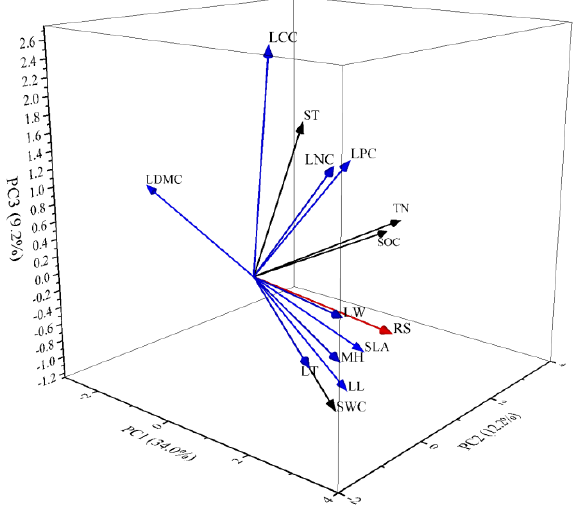
Figure 4. MFA ordination of soil respiration and community functional traits. (Legend: The direc- tion of the arrow indicates the positive and negative correlations between the research variables and the sorting axis, and the length of the arrow line represents the strength of the relationship between research variables and sorting axis. Rs − soil respiration, MH − Maximum height, LL − Leaf length, LW − Leaf width, LT − Leaf thickness, LDMC − Leaf dry matter content, SLA − Specific leaf area, LCC − Leaf carbon content, LNC − Leaf nitrogen content, LPC − Leaf phosphorus content, ST − Soil temperature, SWC − Soil water content, TN − Total nitrogen, and SOC − Soil organic content) Rs was significantly positively correlated with maximum height ( p < 0.01). Previous